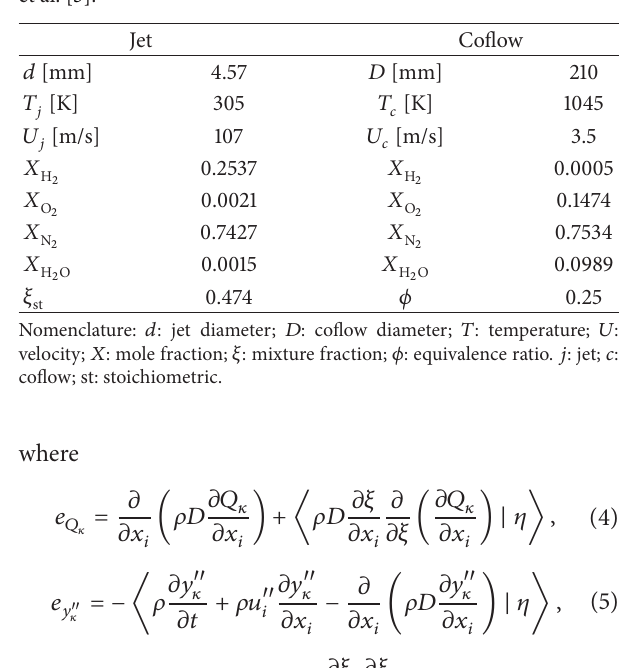
Table 1: Conditions of the jet and coflow in the lifted flame of Cabra et al.